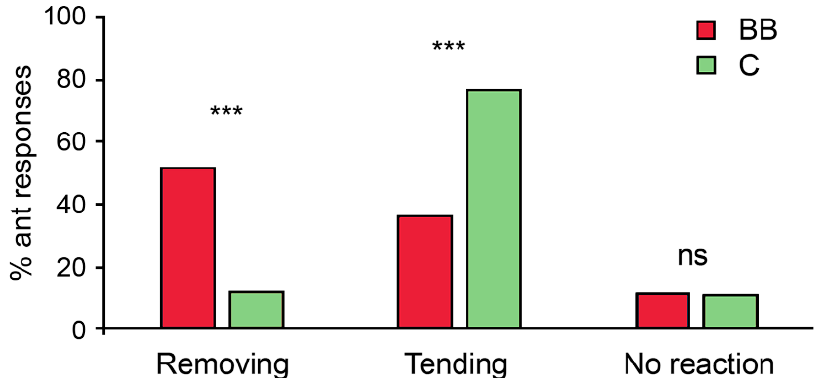
Figure 4. The percentage of different responses of Lasius fuliginosus aphid milkers towards Chaitophorus populeti aphids contaminated with Beauveria bassiana (BB) or uncontaminated control aphids (C) immediately after their first encounter. Fischer’s exact two-tailed test: *** p < 0.0001, ns— p > 0.05.